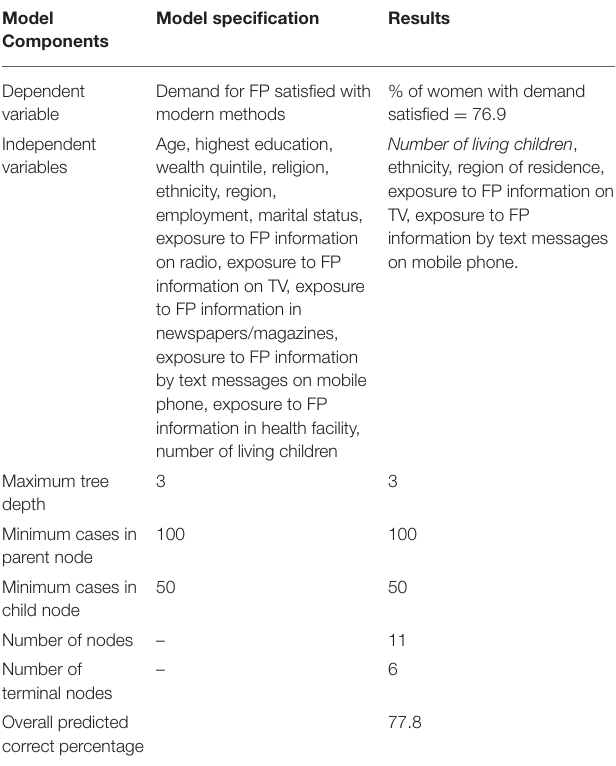
TABLE 4 | Summary information of the specifications used to build the CHAID model for all urban women. Model